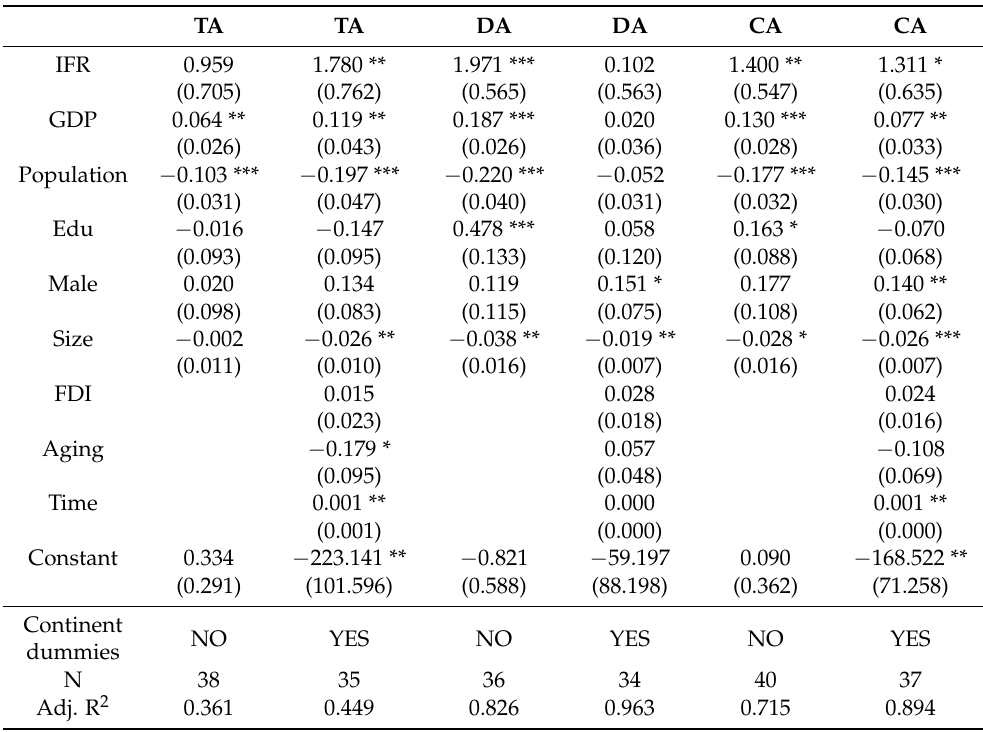
Table 4. The associations of the infection fatality ratio and different sorts of appliances that were applied in distance education by using the robust OLS